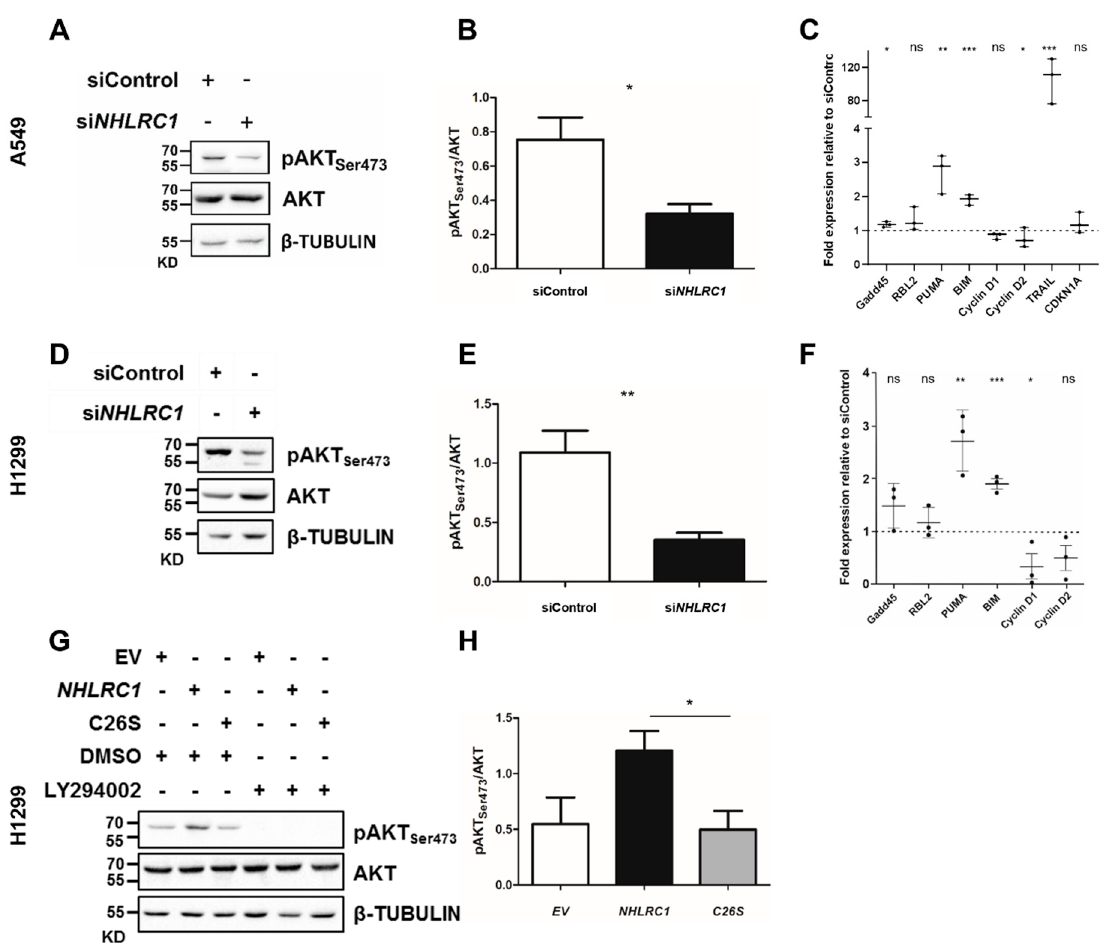
Figure 5. AKT activation and its downstream effects in lung cancer NHLRC1 knock-down and overexpressing cells. ( A , D ) Representative Western blots probed for pAKT Ser473 , AKT and beta-TUBULIN of lung cancer cell lines A549 ( A ) and H1299 ( D ) at 48 h after NHLRC1 knock-down or control treatment. ( B , E , H ) Quantification of ratios from Western blot signals for pAKT Ser473 and AKT normalized to beta-TUBULIN. ( C , F ) Relative mRNA expression levels for FOXO-regulated genes in A549 ( C ) and in H1299 ( F ) NHLRC1 knock-down cells versus control cells. ( G ) Representative Western blots probed for pAKT Ser473 , AKT and beta-TUBULIN H1299 cells overexpressing at 36 h, compared to empty vector (EV) and NHLRC1 C26S catalytic mutant (C26S) expressing cells. Cells were treated with 50 µM of the PI3K inhibitor LY294002 or with DMSO as control for 1 h. ( H ) Quantification of ratios from Western blot signals for pAKT Ser473 and AKT normalized to beta-TUBULIN. NHLRC1 : NHL repeat containing 1, siControl: siRNA control-treated cells, si NHLRC1 : NHLRC1 siRNA pool-treated cells, KD: Kilo-Dalton, GADD45 : growth arrest and DNA damage-inducible 45, CDKN1A: cyclin dependent kinase inhibitor 1A , RBL2: RB transcriptional corepressor like 2 , BIM: BCL2 like 11 , PUMA: BCL2 binding component 3; Raw blots are available as Supplementary raw blot S1 and 2 for NHLRC1 siRNA KD and Supplementary raw blot S2 for NHLRC1 overexpression experiments. Two-tailed t -test p -values, *: p < 0.05, **: p < 0.01, ***: p < 0.001, ns: not significant.